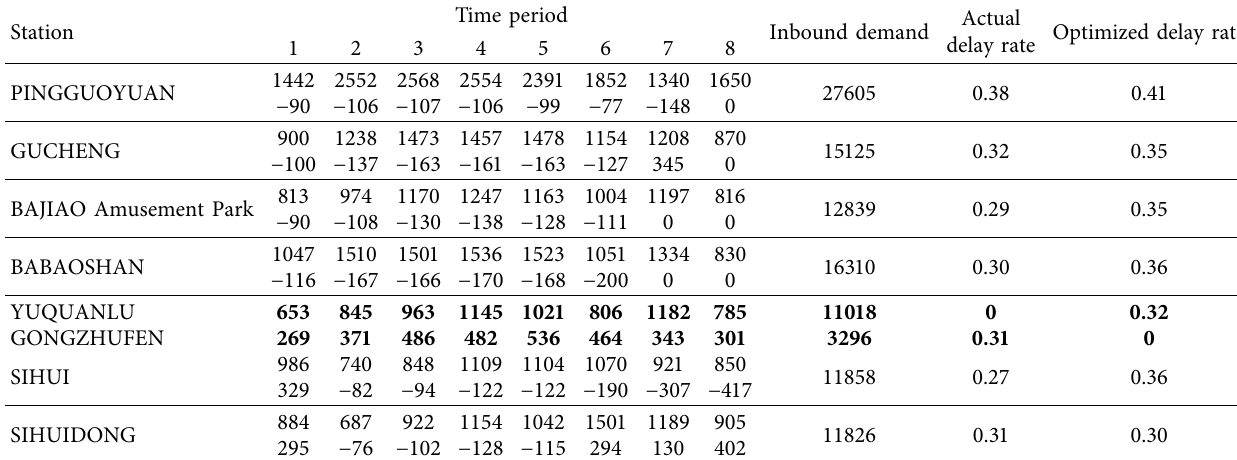
Table 6: Comparison between the actual and coordinated control strategies for Line